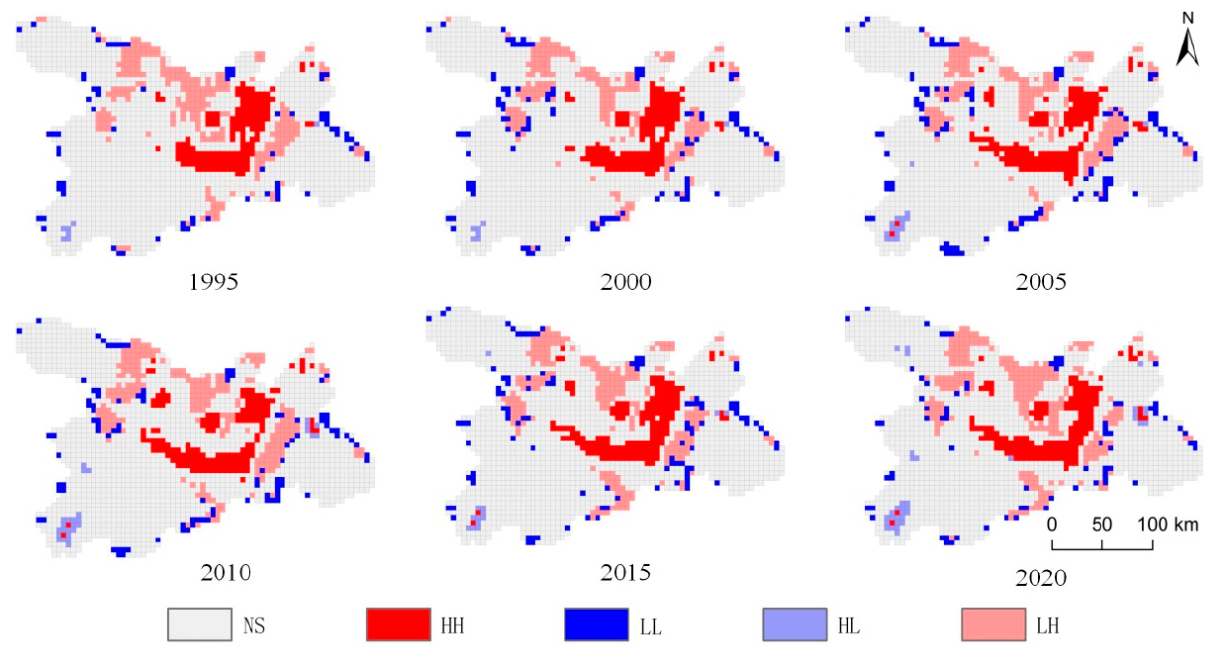
Figure 6. Spatial autocorrelation between ecosystem service value per unit area and ecological risk index from 1995 to 2020: NS, not significant; HH, high value/high risk; LL, low value/low risk; HL, high value/low risk; LH, low value/high risk.